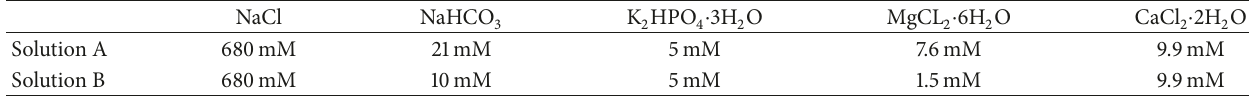
Table 1: Composition of SBF coating solutions.